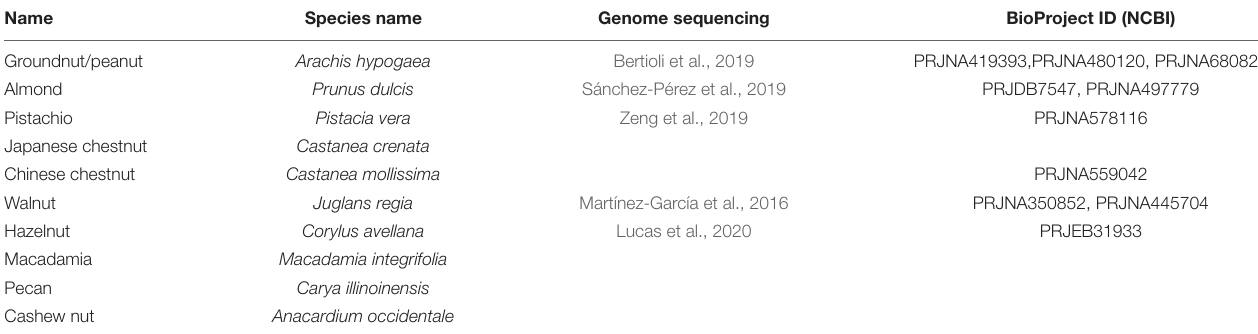
TABLE 1 | Nut plant species presented in this